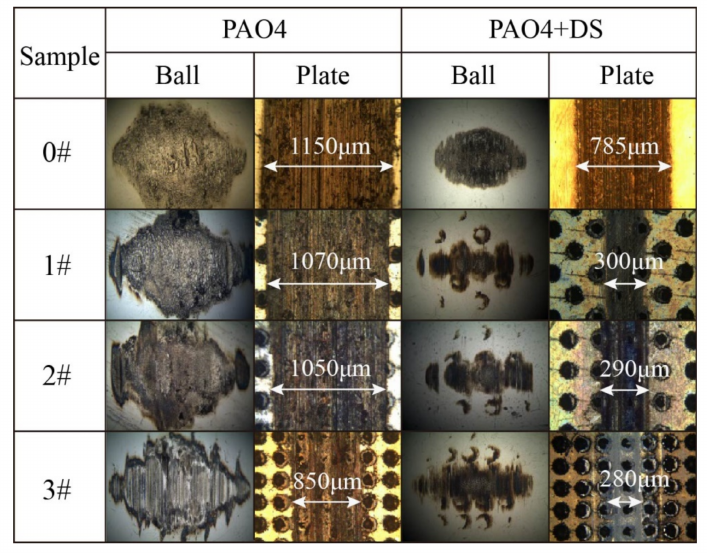
Figure 8. Optical microscopy of the worn surfaces ( T = 100 ◦